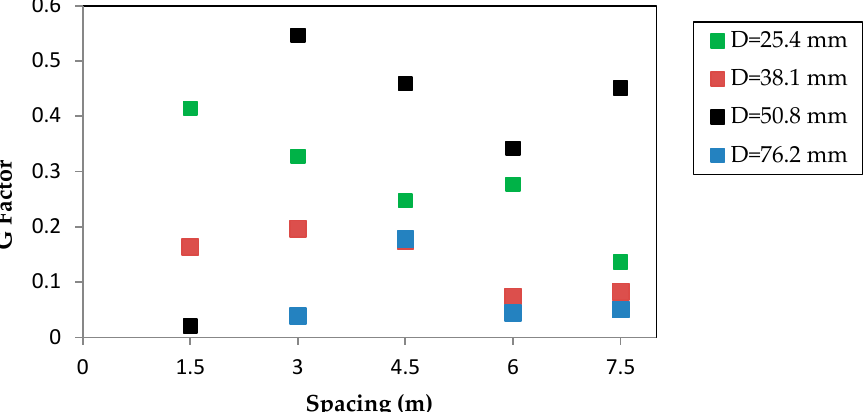
Figure 7. Variation of the experimental G factor for various outlet spacings (inlet head = 1.7 m).